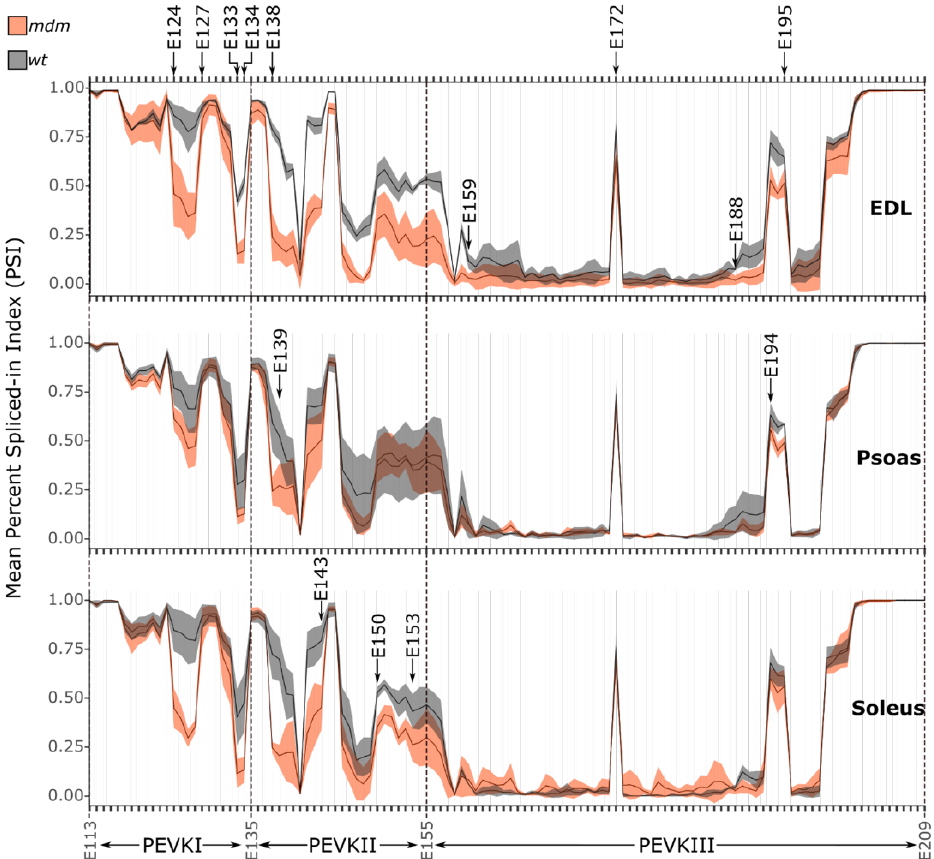
Figure 2. PEVKI and PEVKII exons have significantly lower expression levels in mdm muscles. Expression of PEVK exons in mdm muscles (red) and WT muscles (grey) varied among regions, with the most variations occurring in PEVKI and PEVKII. PSI index varies from 0 = complete exclusion to 1 = complete inclusion in the transcript pool. The shaded area shows the standard deviation of mean PSI values. Exons undergoing an expression drop in more than one muscle type are shown at the top. Exon regions specific to each muscle are shown in the respective rows. Two-way ANOVA demonstrated significant downregulation of exons 124 – 127, 133 – 134, 138 – 145, and 194 in mdm compared to WT, all p < 0.0029).